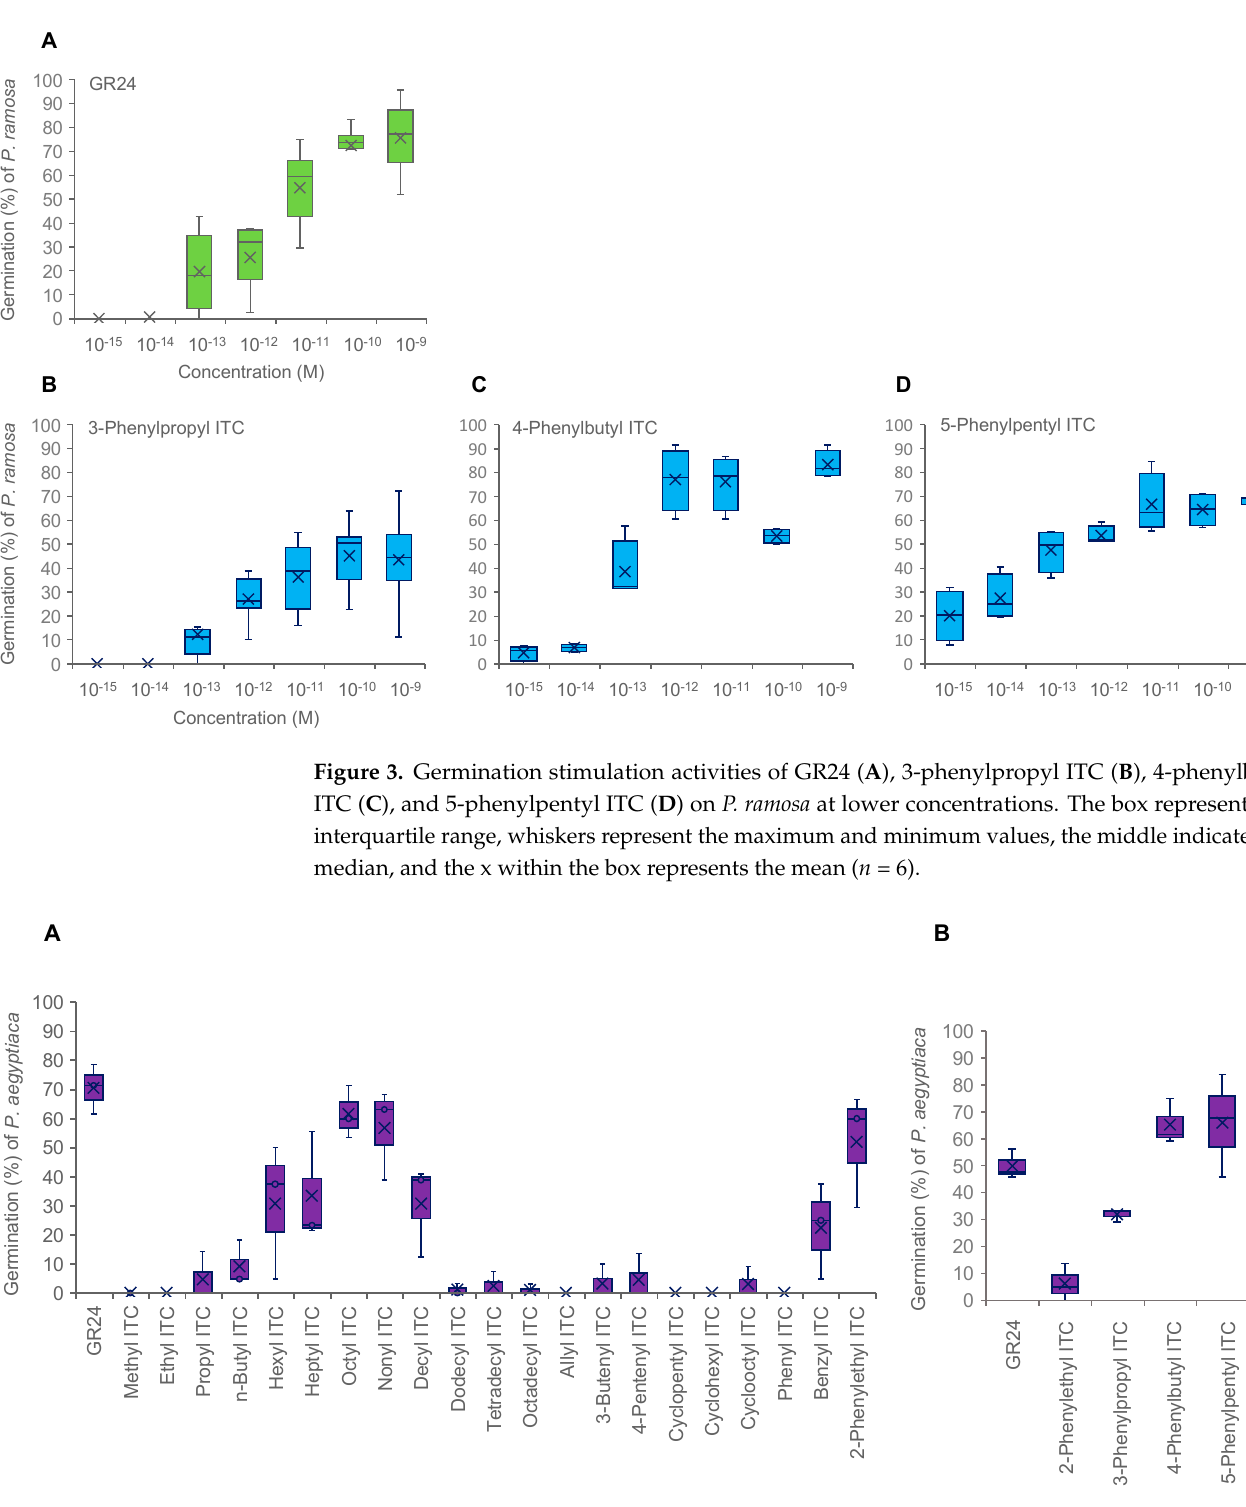
Figure 4. Germination stimulation activities of ITCs on P. aegyptiaca seeds . The activities were examined at 10 − 6 M ( A ) and 10 − 8 M ( B ). The box represents the interquartile range, whiskers represent the maximum and minimum values, the middle indicates the median, and the x within the box represents the mean ( n = 3).